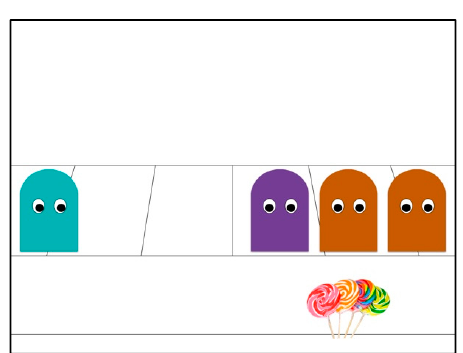
Figure 2. Exclusion scene outcome.